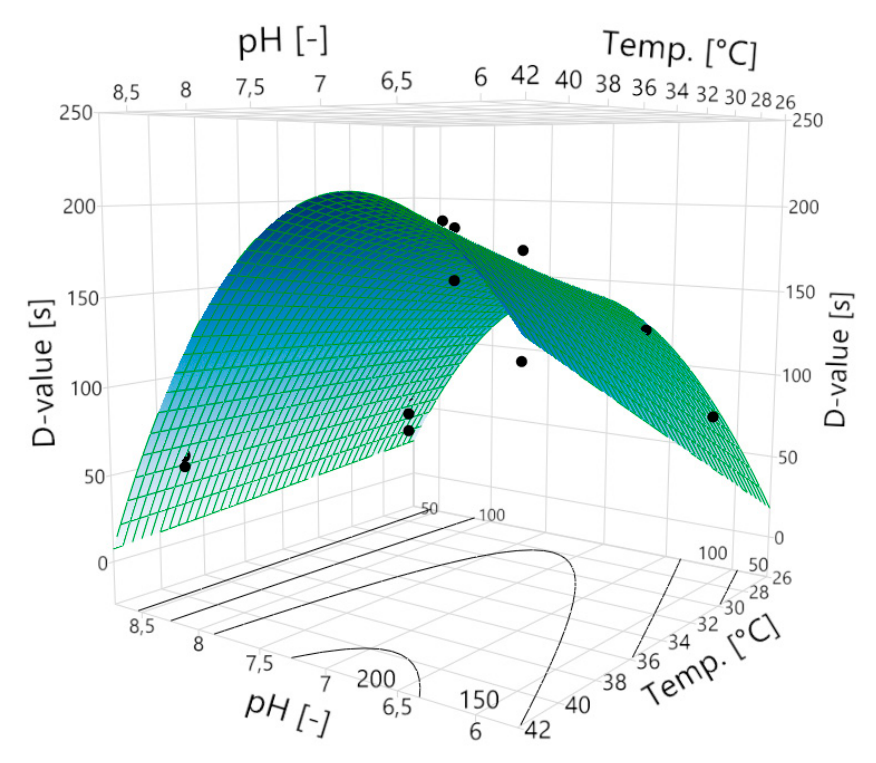
Figure 2. Dependence of the D-value on the temperature and pH. The surface plot shows the expected D-values for the respective sporulation conditions. The black data points are the actually measured D-values on which the model is based. Some of the values are hidden by the surface. The D-value is greatest at a high temperature of 40 °C and a pH of 6.9. If the temperature drops or the pH changes to acidic or basic, the D-value also decreases.